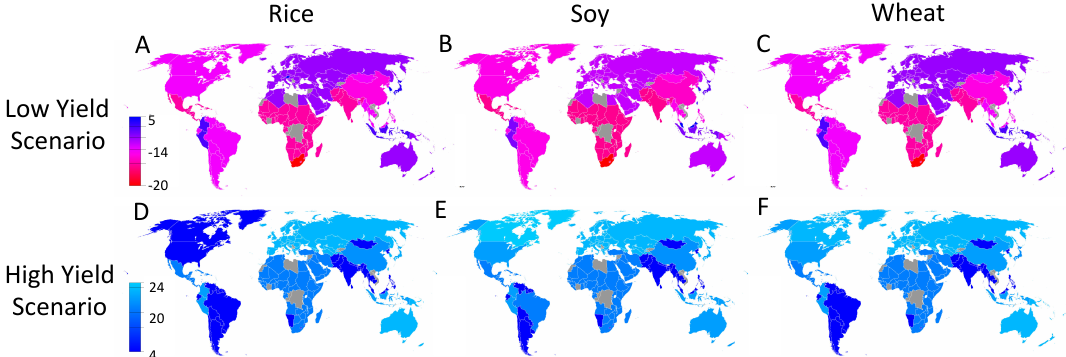
Fig. 2. Maps of yield shocks by country, crop, and scenario. The first row ( a, b, c ) shows the yield shocks for the low-yield scenario; the second row ( d, e, f ) shows the yield shocks for the high-yield scenario. The first column ( a, d ) shows yield shocks for rice; the second column ( b, e ) shows yield shocks for soy; the third column ( c, f ) shows yields shocks for wheat. The colors indicate the percentage change [%] in yield between 2001 and 2030; Grey indicates countries without data.